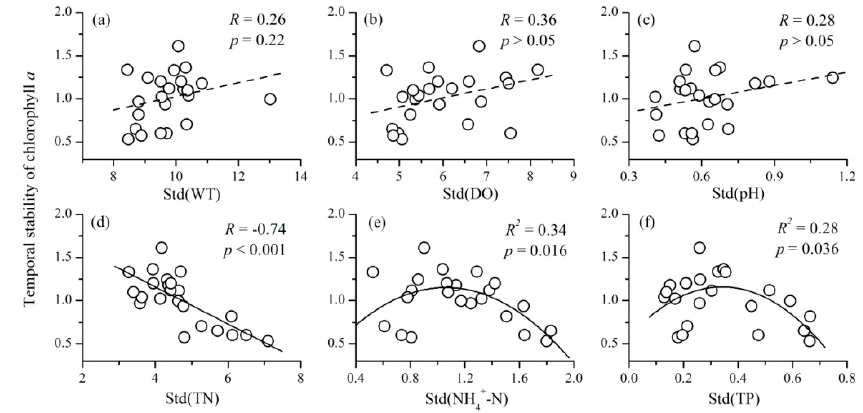
Figure 7. The relationships between the variability of ( a ) water temperature (WT); ( b ) dissolved oxygen (DO); ( c ) pH; ( d ) total nitrogen (TN); ( e ) ammonia nitrogen (NH 4+ ‐ N); ( f ) total phosphorus (TP) and the temporal stability of phytoplankton biomass (chlorophyll a ) in Lake Qixinghu. Std: standard deviation. The fitting of regression equations is calculated using the 23 sample sites in the lake (all N = 23).